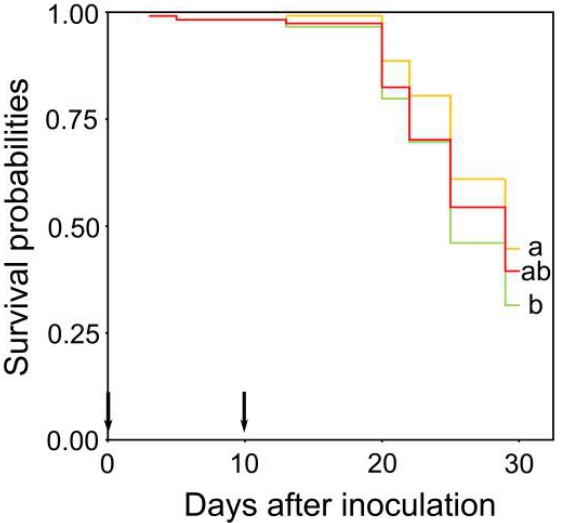
Figure 4. Survival probabilities of Castanea sativa seedlings exposed to ambient temperature (green), high ambient temperature (orange) and heat waves (red) and infected at day 0 with Phytophthora cinnamomi . Global log-rank test was significant at p = 0.080. Different letters indicate significant differences between survival curves ( p < 0.05) and arrows indicate the dates of phenol assessment.